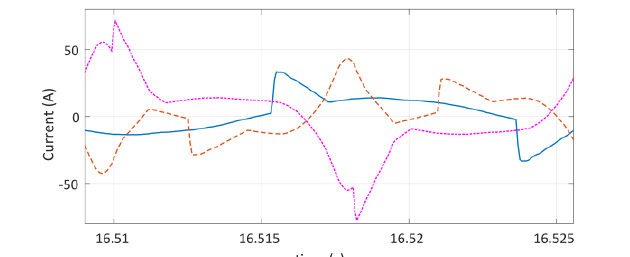
Fig. 11. Waveform in 𝑀 1 with 𝑇𝐻𝐷 𝑖 - 𝐼 𝐺 + 𝑁 𝐿 connected. Table XIV. Values in 𝑀 1 with 𝑇𝐻𝐷 𝑖 - 𝐼 𝐺 + 𝑁 𝐿 connected.